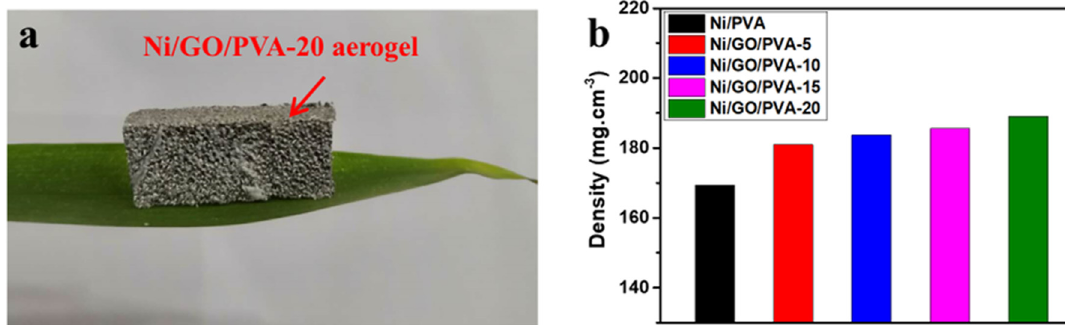
Figure 2: ( a ) Photograph of Ni/GO/PVA - 20 aerogel; ( b ) histogram of aerogel